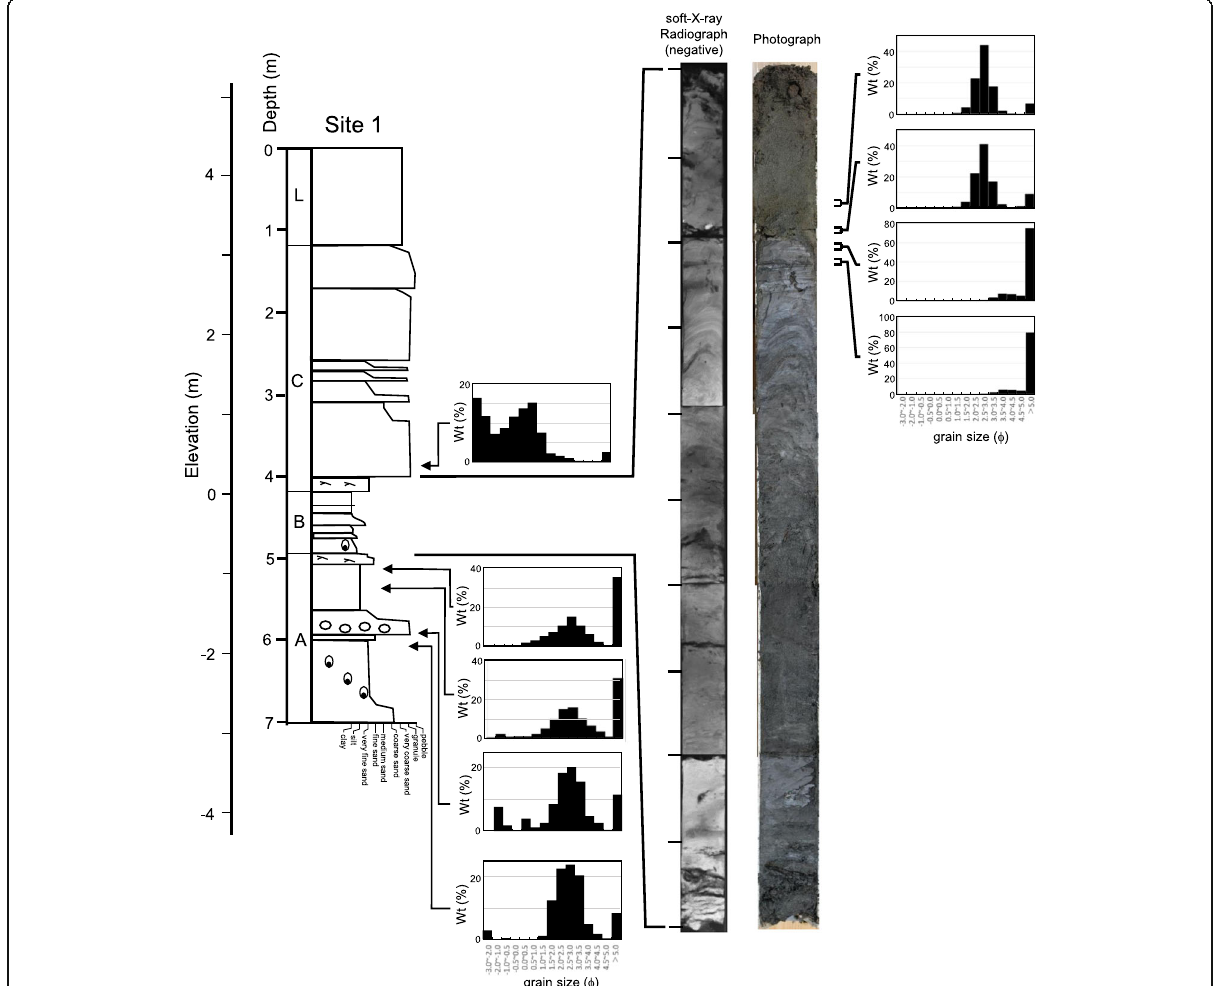
Fig. 6 Grain-size distribution of cored sediments at site 1. See Fig. 5 for legend